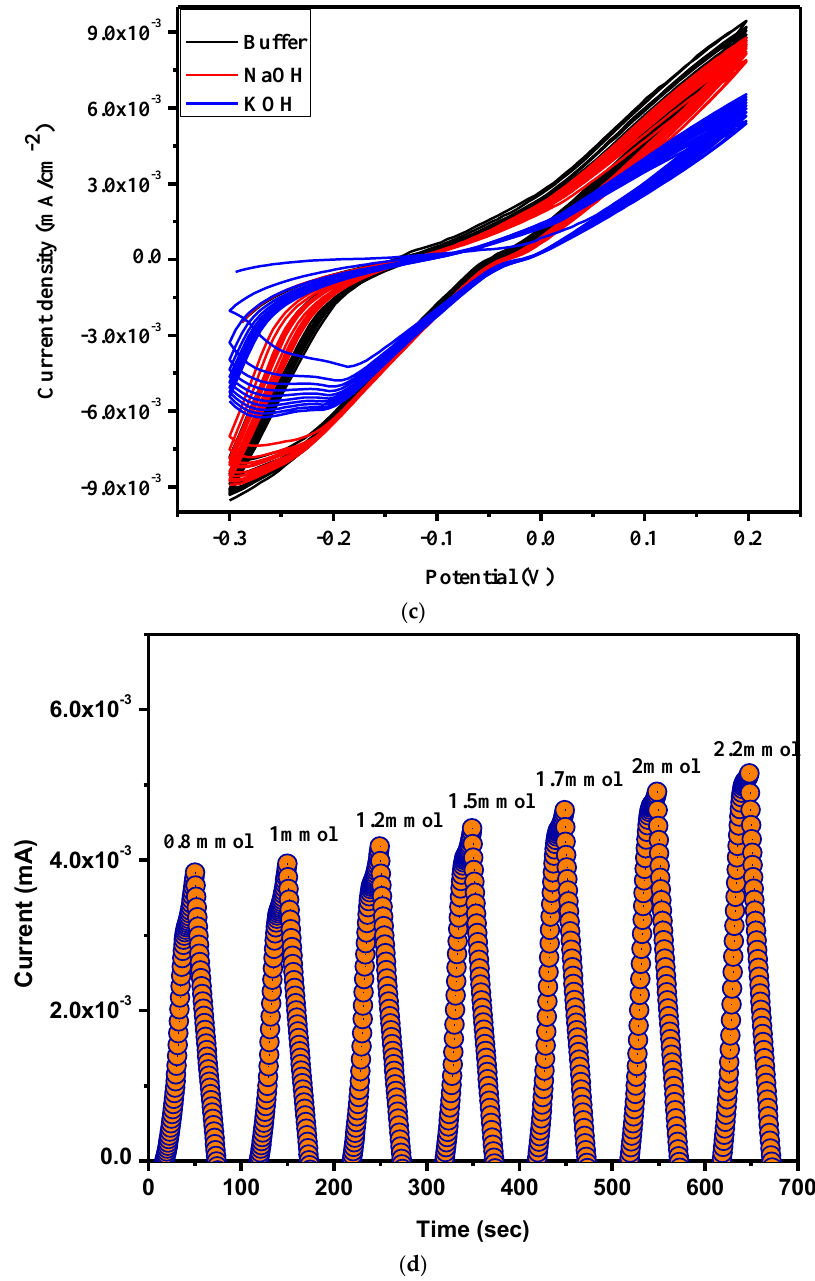
Figure 6. ( a ) Cyclic voltammogram of ZrO 2 -Ag, ZrO 2 -Ag-G, and ZrO 2 -Ag-G-SiO 2 electrode in urine in the absence of glucose at a scan rate of 10 mV s − 1 (pH 7.0); ( b ) Cyclic voltammogram of ZrO 2 -Ag, ZrO 2 -Ag-G, and ZrO 2 -Ag-G-SiO 2 sample with 0.05 mmol/L glucose in urine at a scan rate of 10 mV s − 1 (pH 7.0); ( c ) Cyclic voltammogram of ZrO 2 -Ag-G-SiO 2 sample with different electrolyte: 0.1 M PO 43- Buffer (pH 7.4); 0.1 M NaOH (pH 13) and KOH (pH 13.5) at a scan rate of 10 mV s − 1 with the addition of 0.55 mmol/L glucose. ( d ) (i-t) curve of ZrO 2 -Ag-G-SiO 2 sample with different conc. of glucose in 0.1 M PBS (pH 7.4). All experiments were run at room temperature (20 °C). There was a poor oxidation peak observed in Figure 6a in the absence of glucose. In contrast, ZrO 2 -Ag, ZrO 2 -Ag-G, ZrO 2 -Ag-G-SiO 2 electrodes showed a well-defined oxida- tion peak at the potential of +0.2 V. By adding 0.05 mmol/L of glucose, a poor response was noticed with the ZrO 2 -Ag rather than ZrO 2 -Ag-G and ZrO 2 -Ag-G-SiO 2 electrode in the presence of glucose, due to the high bandgap energy of ZrO 2 . After combining with Ag nanoparticle and graphene, the bandgap energy-reduced and ZrO 2 -Ag-G, ZrO 2 -Ag-G,